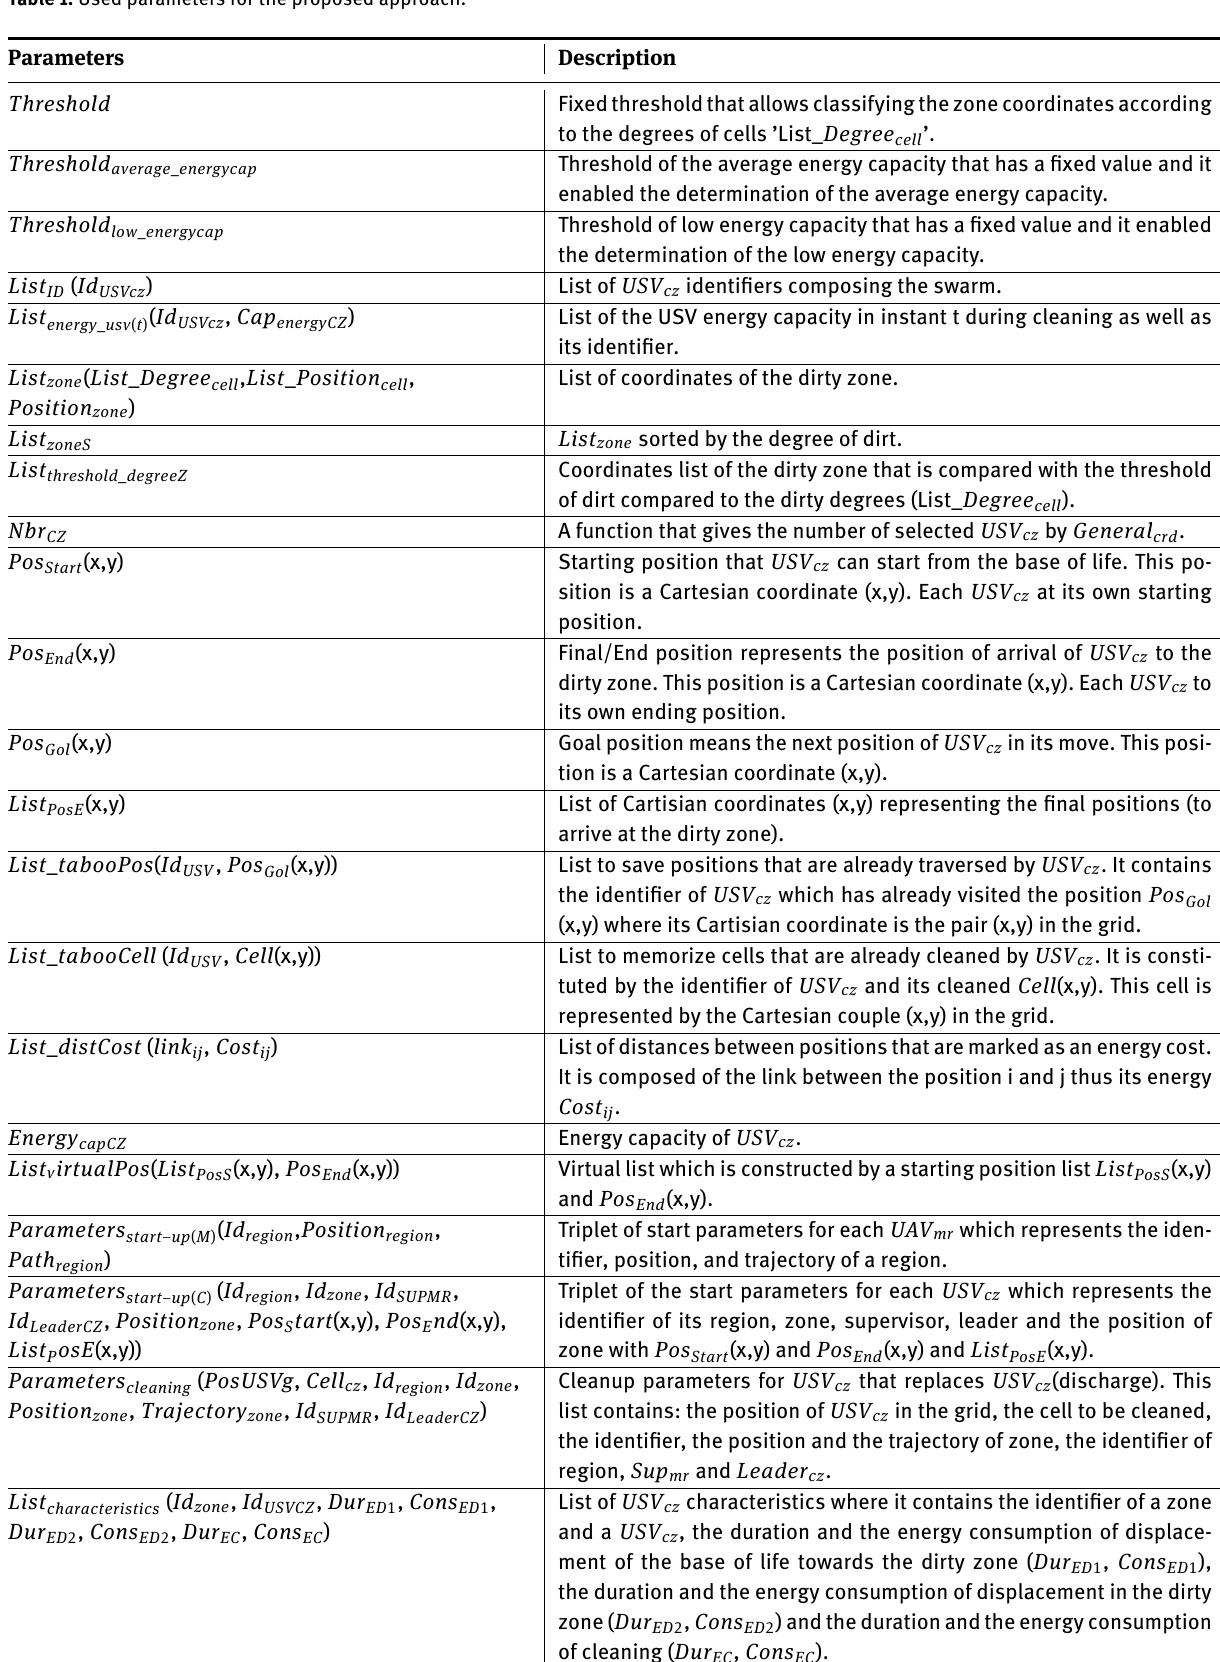
Table 1: Used parameters for the proposed approach. Parameters